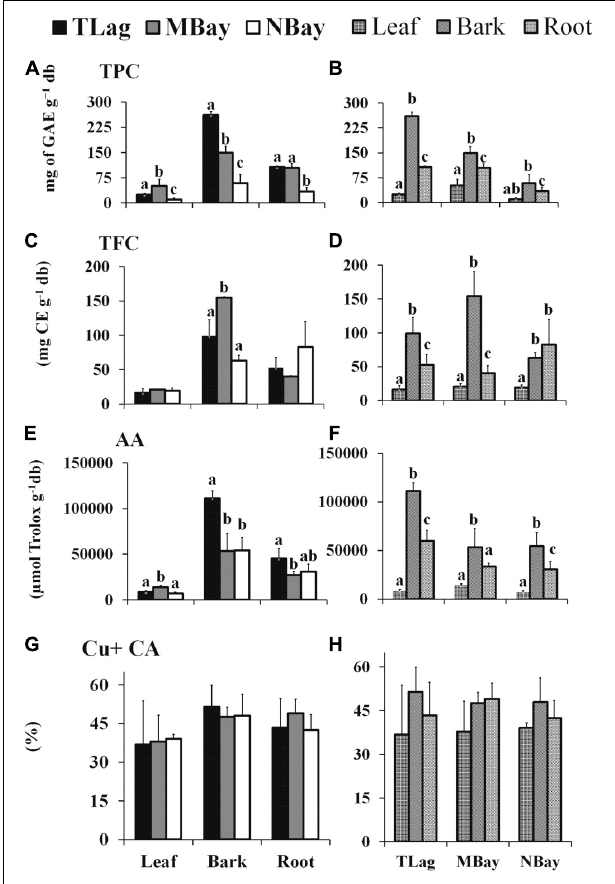
FIGURE 2 | Biocompounds concentrations (A–D) (average ± SD), AA (E,F) , and chelating activities (G,H) of leaves, bark, and roots of R. mangle among and within MBAY, NLAG, and TLAG. Different letters show significant statistical differences ( p ≤